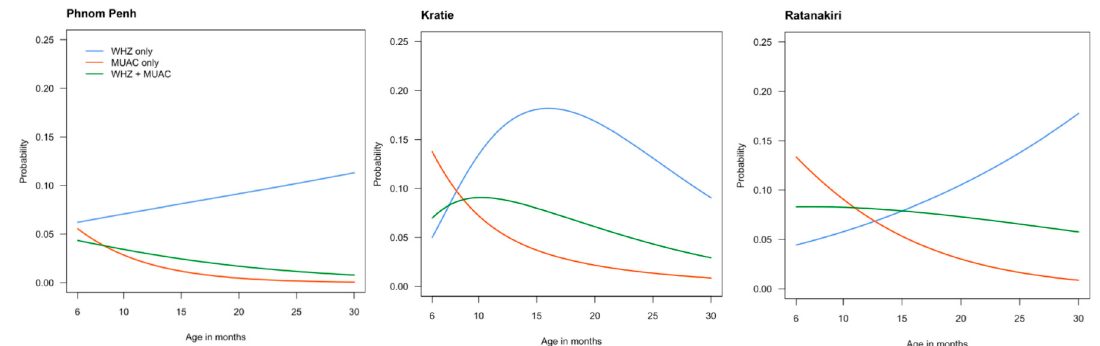
Figure 2. Prevalence of wasting in the three study sites, when using WHZ alone (< − 2 Z-score) or MUAC alone (<12.5 cm). The group WHZ + MUAC consists of children having both a WHZ < − 2 Z scores and a MUAC < 12.5 cm.